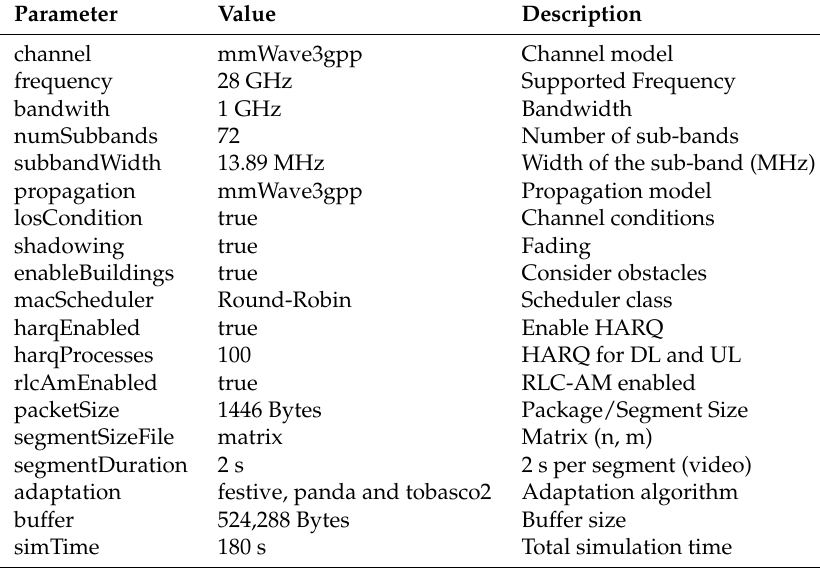
Table 4. Simulation